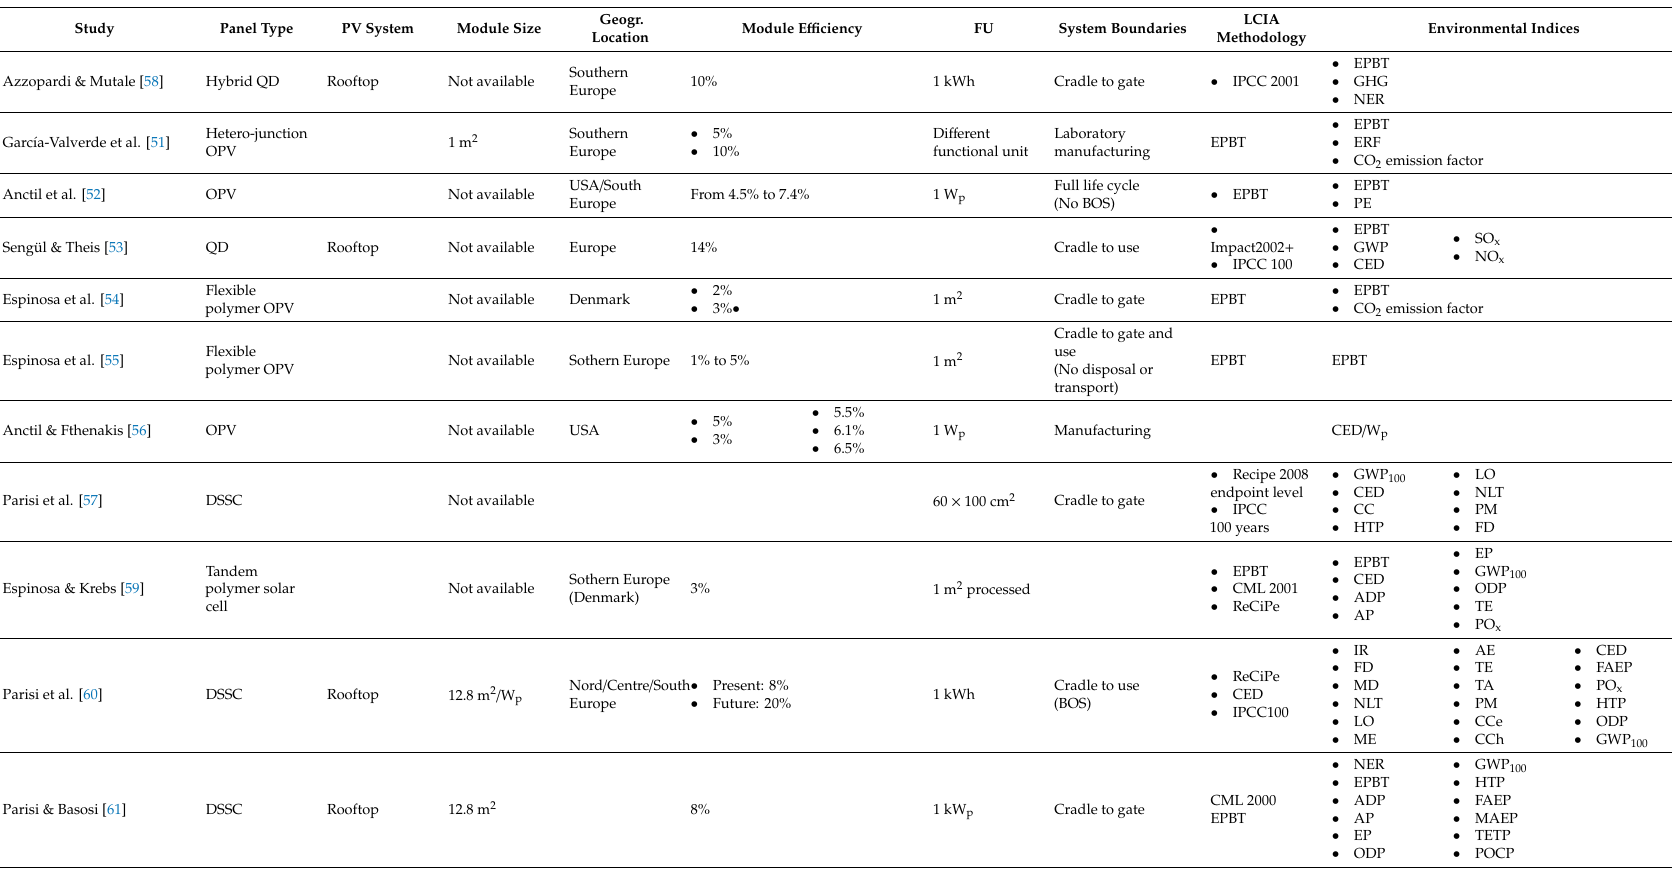
Table 15. Summary of key-parameters and methodological aspect of the examined case studies (third